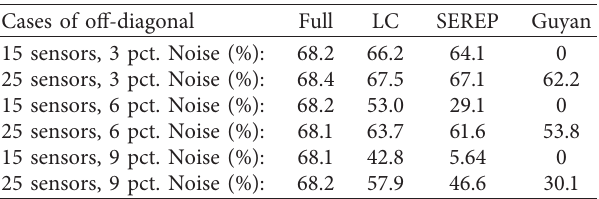
Table 2: The percentages of the simulation results where the largest off-diagonal element in the XOR matrices stays within the threshold of 0.1.